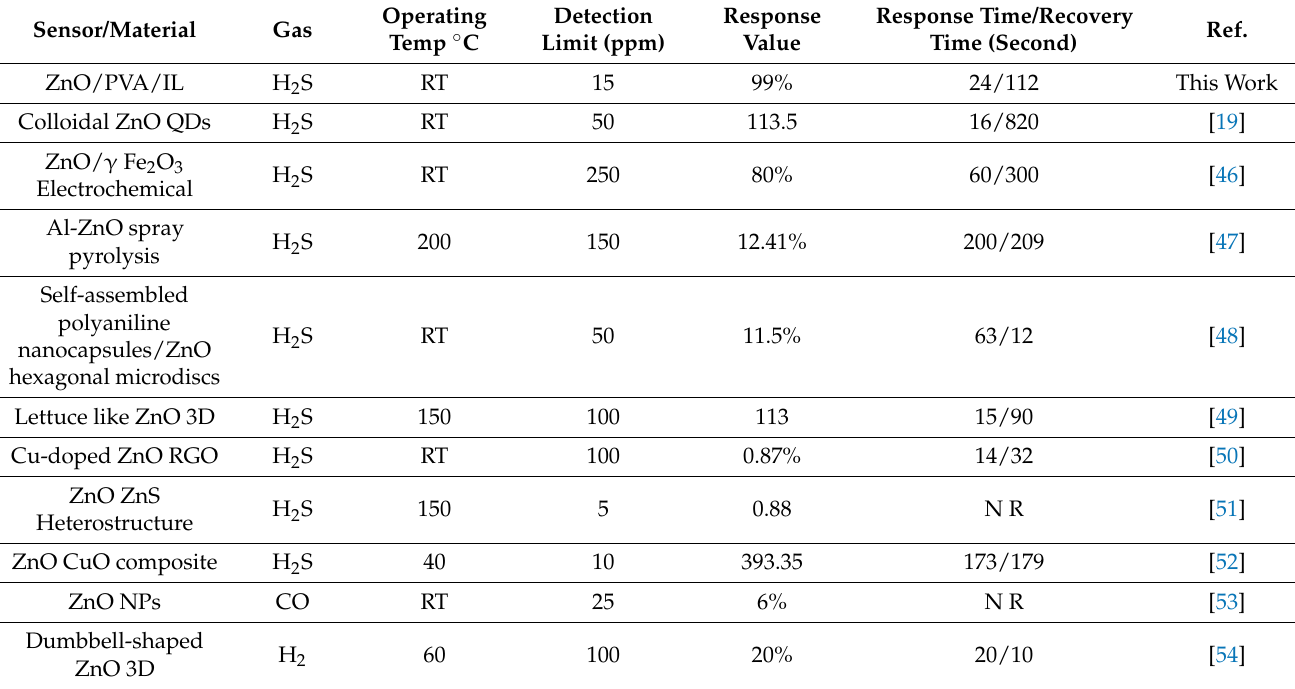
Table 1. A comparison of the sensor’s performance with the reported